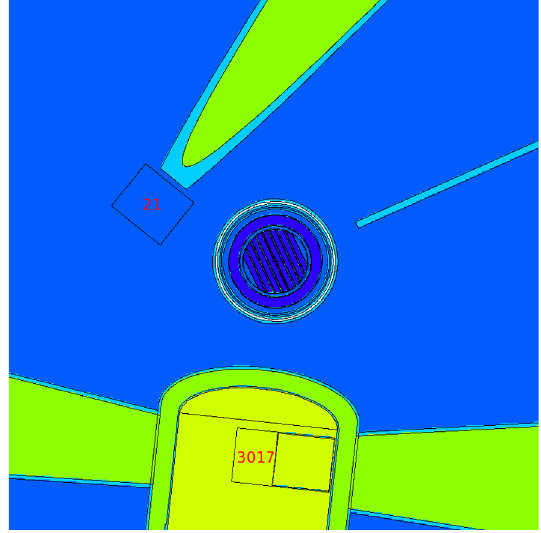
FIG. 11. Power density in the central rod (only in the lead) of row 3. The relative error of the values is below 3%.